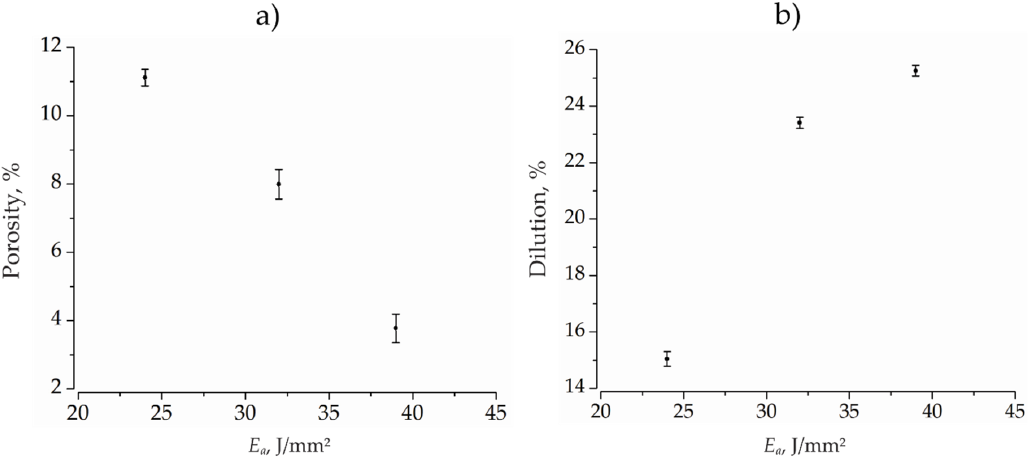
Figure 2. Influence of average energy per unit area ( E a ) on ( a ) porosity content, and ( b ) dilution.